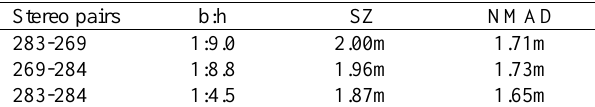
Table 10. Differences Pleiades DSMs against reference DTM